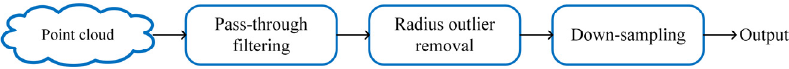
Figure 1. Overview of the proposed large-scale aircraft pose estimation system.